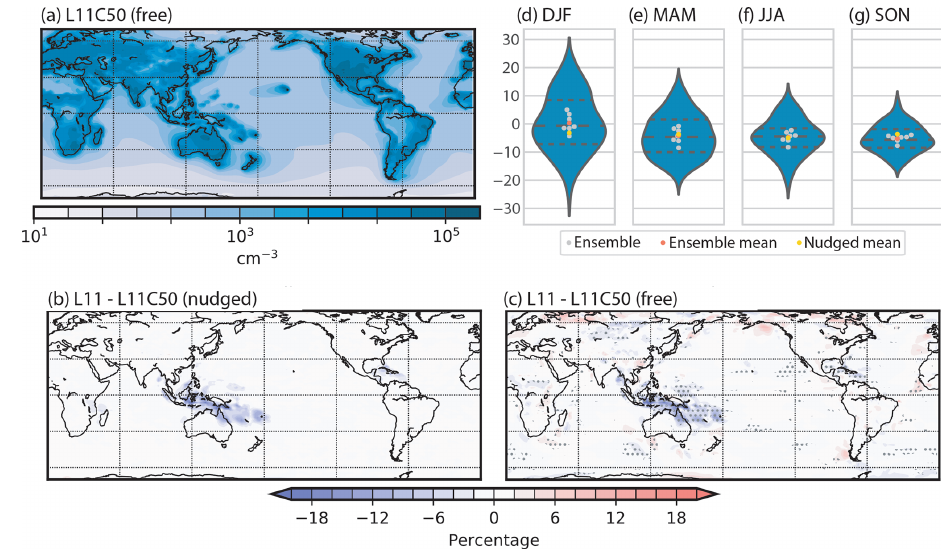
Figure 6. As for Fig. 4 but for N 3 in number per cubic centimetre (cm − 3 ) (a) and percent (b–g) .